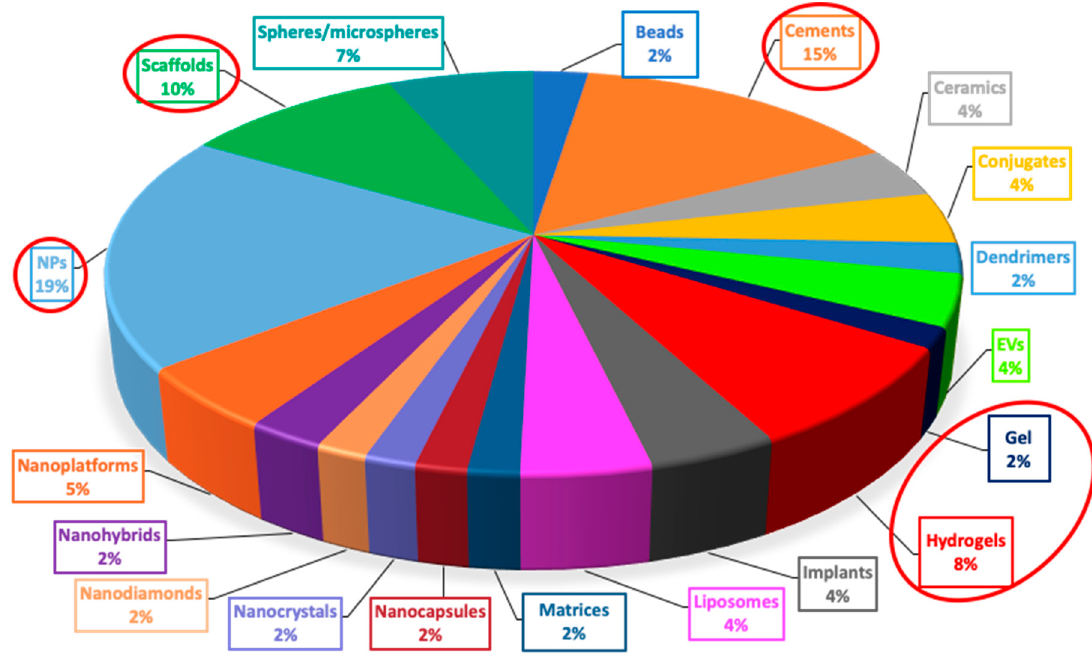
Figure 6. Schematic diagram showing citing frequency of each bone drug delivery approach as percentage of total number of the studies cited in this review.